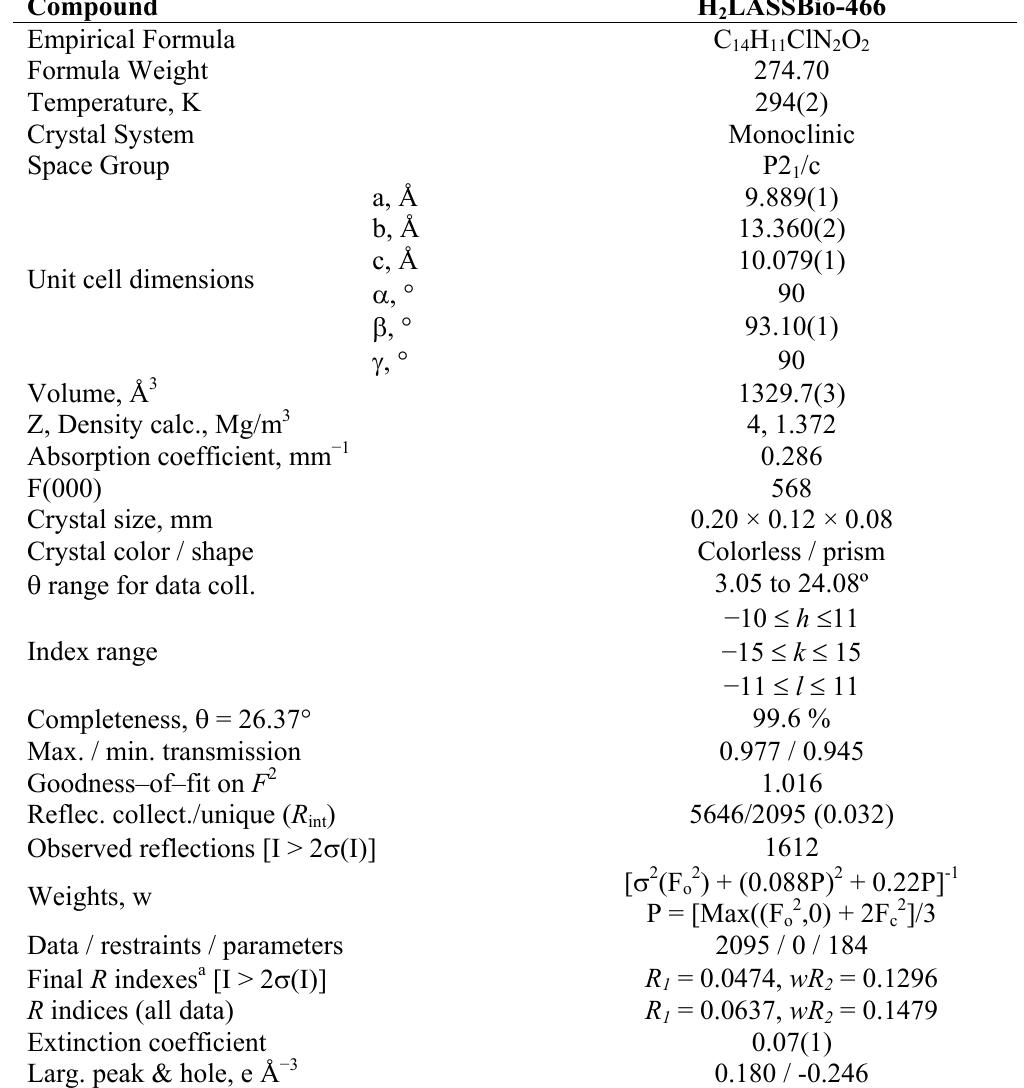
Table 1. Crystal data and structure solution methods and refinement results